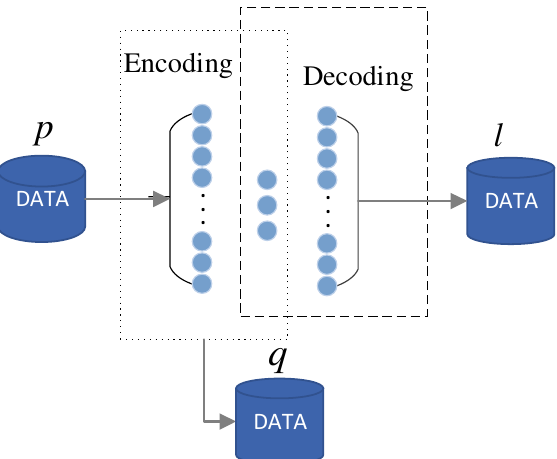
Figure 2. Autoencoder Network Model.